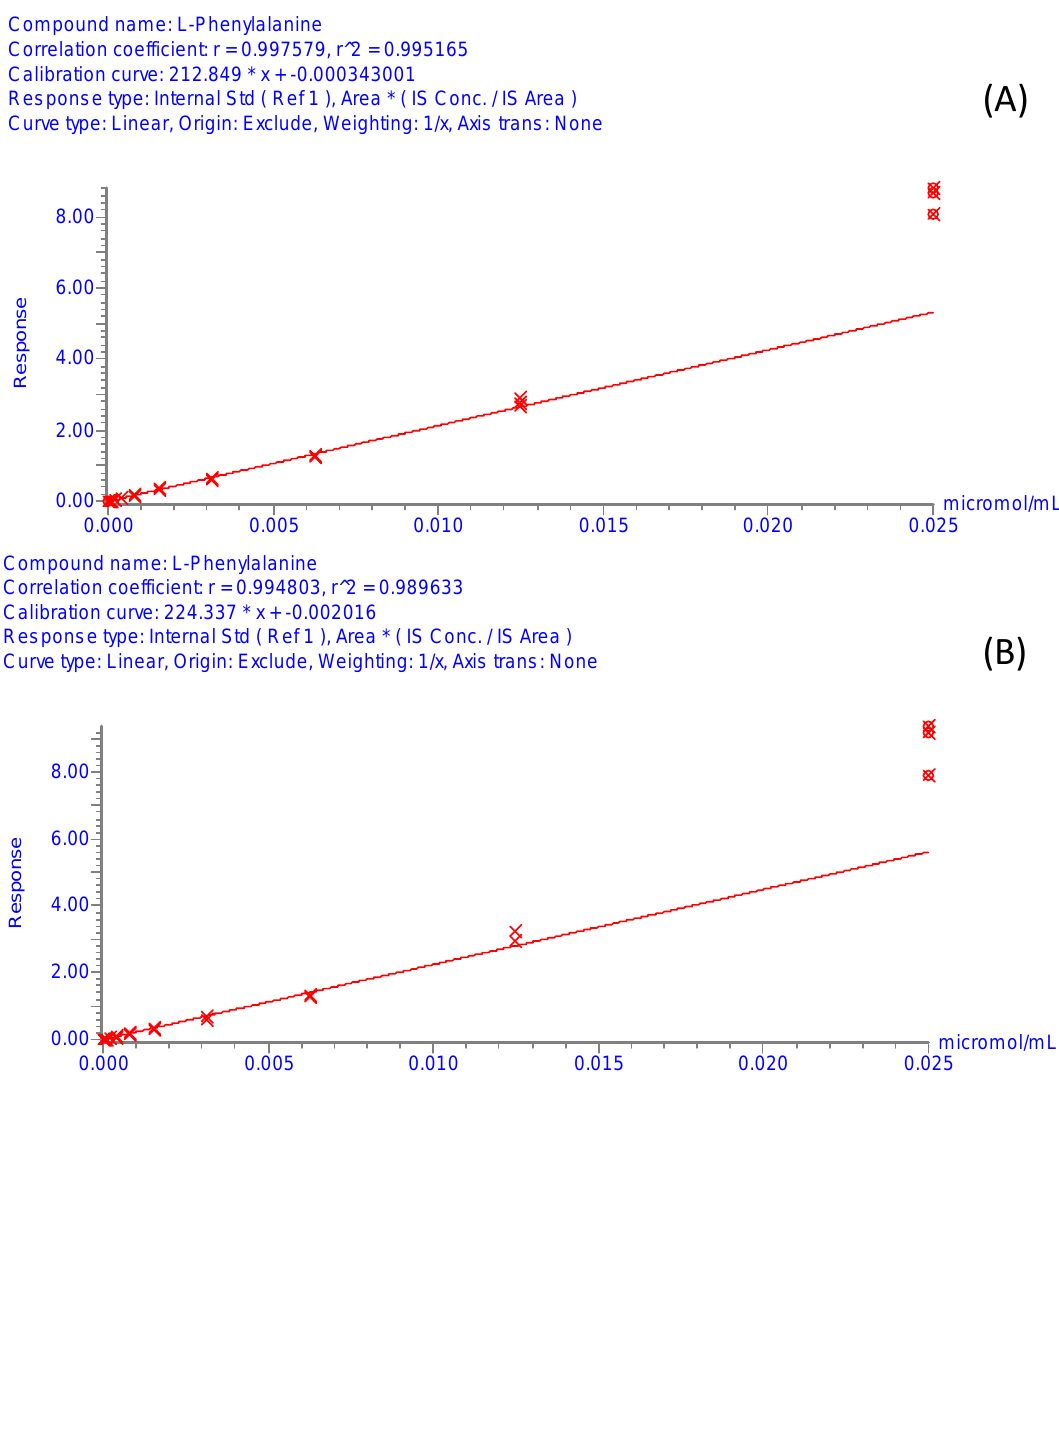
Figure S1. Internal calibration curves for phenylalanine. Experimental conditions: Standard solutions of phenylalanine covered the concentration range from 2.5 × 10 − 5 M to 4.77 × 10 − 11 M, linear dynamic range observed from 1.25 × 10 − 5 M to 1.22 × 10 − 8 M. Internal standard (4-Hydroxyphenyl-2,6-d -alanine-2-d -01) at 4 × 10 − 4 g/L. 1 μ L of 2 1 sample was injected. UPLC-ESI-MS/MS analyses were performed as described in Section 3.5. (A) Phenyl alanine and its internal standard were derivatized with AQC using the borate buffer system. (B) Derivatization with AQC in 50mM ammonium acetate (pH 9.3) as the buffering